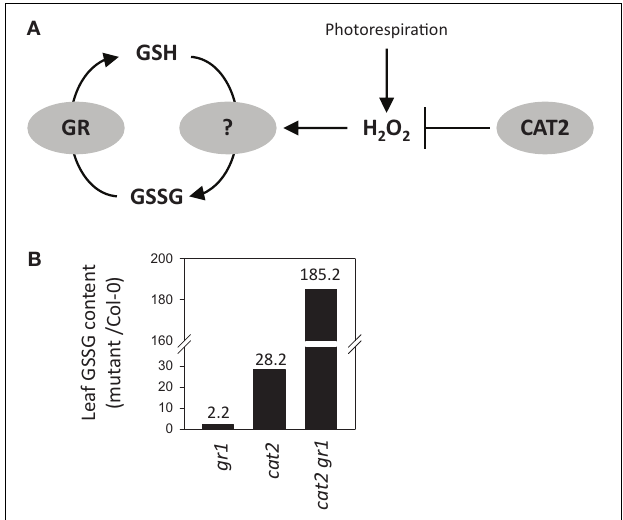
FIGURE 3 | Accumulation of GSSG relative to Col-0 in Arabidopsis knockout mutants for glutathione reductase 1 ( gr1 ), catalase 2 ( cat2 ), or both ( cat2 gr1 ). (A) Simple scheme showing the interplay between GR and H 2 O 2 -triggered oxidation in determining the balance between GSH and GSSG in the mutant systems. (B) Leaf GSSG contents in the three mutant lines relative to Col-0 controls. Fold-change compared to Col-0 GSSG contents are indicated above the